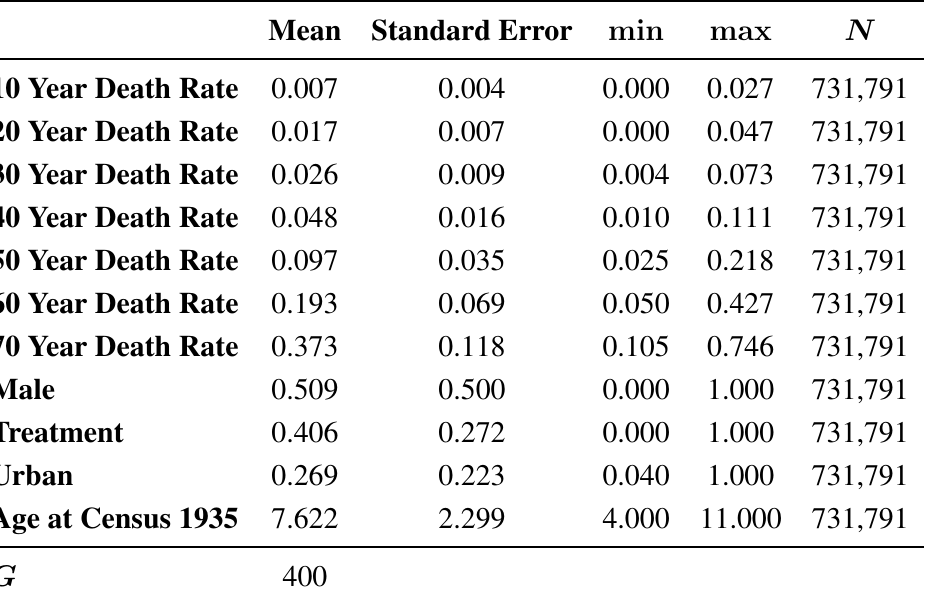
Table 2. Summary